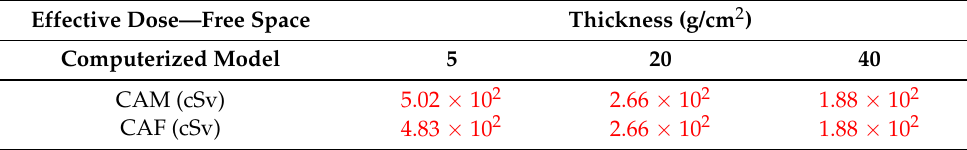
Table 6. Effective doses from 993/4 SPE for CAM and CAF on transit to Mars through free space. NASA’s permissible effective dose limits for 1-year mission is 88 cSv for 40-year old males and 70 cSv for 40-year old females [14].